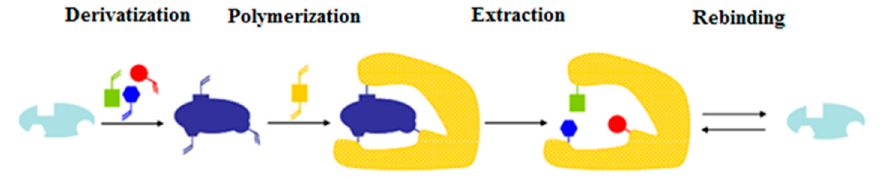
Figure 2. Schematic representation of the covalent imprinting approach.